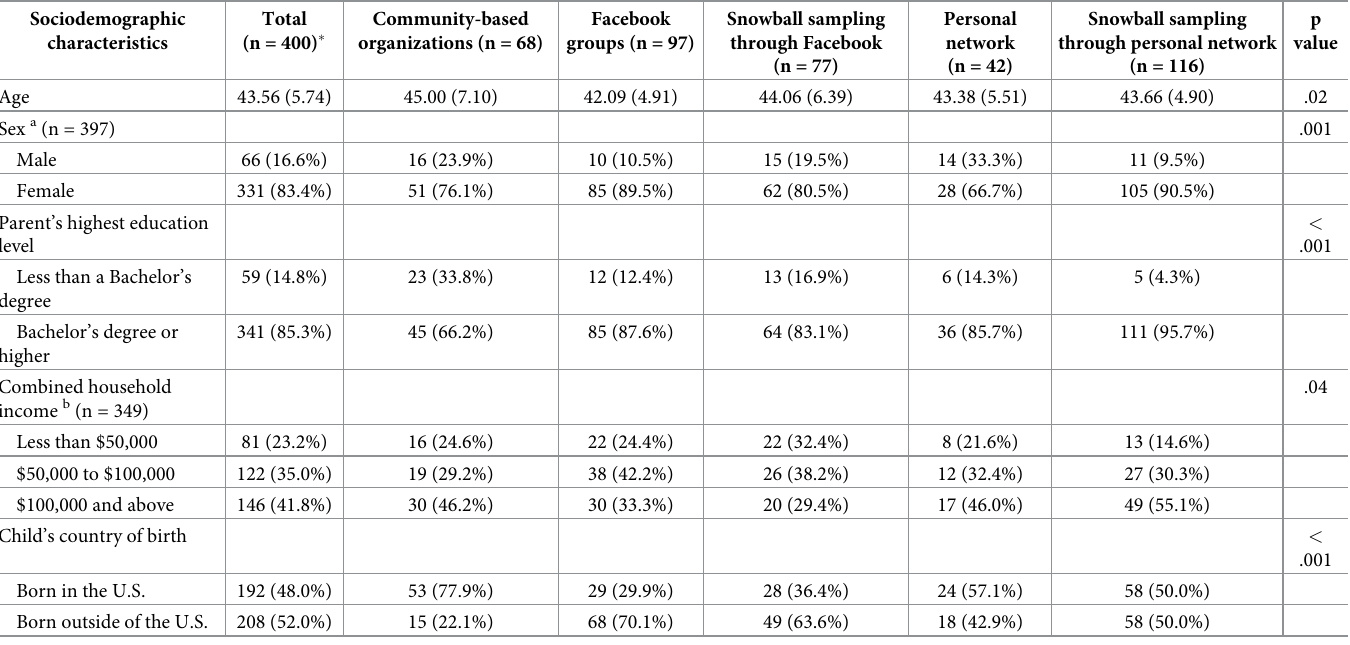
Table 2. Sociodemographic characteristics in relation to recruitment